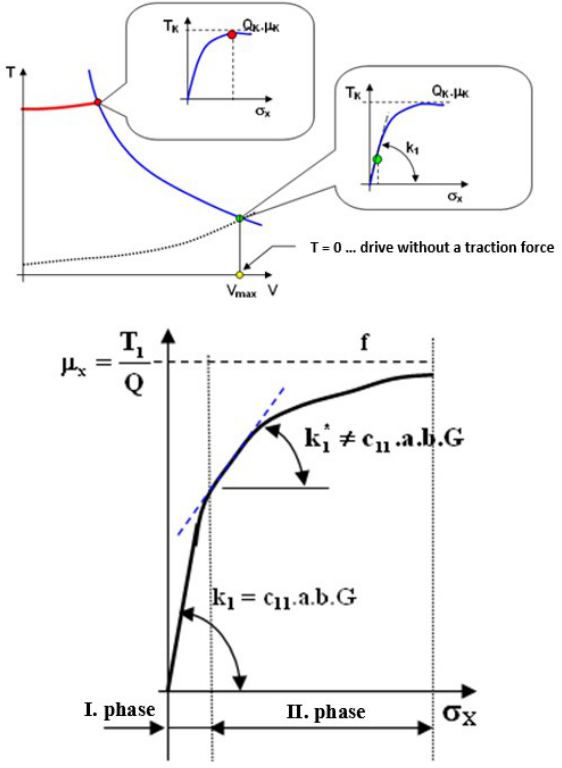
Figure 8. Torsion system scheme – fully-suspended drive.